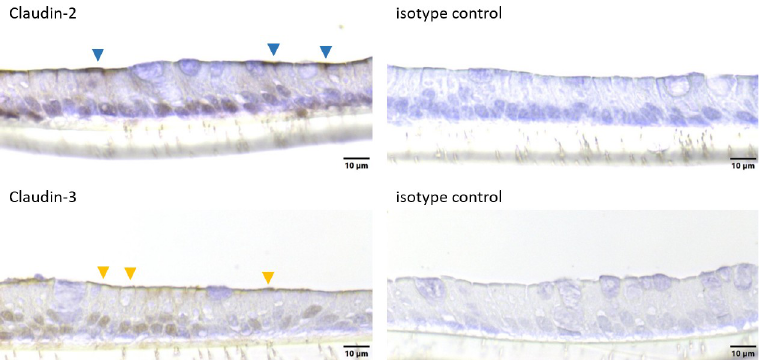
Fig 5. Cellular arrangement (cross sections) of jejunum organoids grown in 2D on Snapwells 1 for 18 days. Immunohistochemical staining (including isotype controls) of Claudin-2 and Claudin-3 was performed. Blue triangles indicate ceklls with positive Claudin-2 signal, orange triangles indicate cells with a positive Claudin-3 signal. Representative figures are shown, chosen from three independent experiments with three technical replicates per staining.